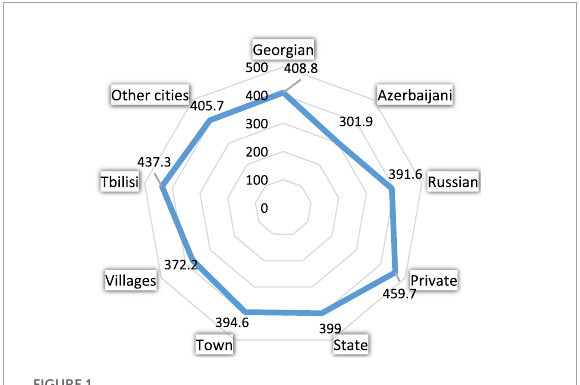
FIGURE1 Students’ grade in mathematics by type of schools.